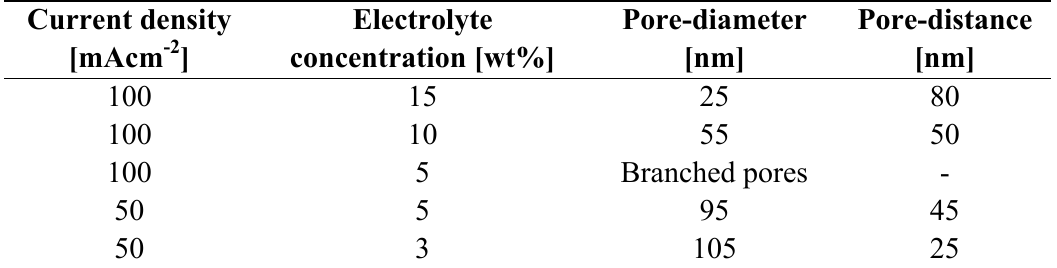
Table 2. PS-morphology parameters in dependence of the electrolyte concentration. As substrate a (100) n + -Si wafer is